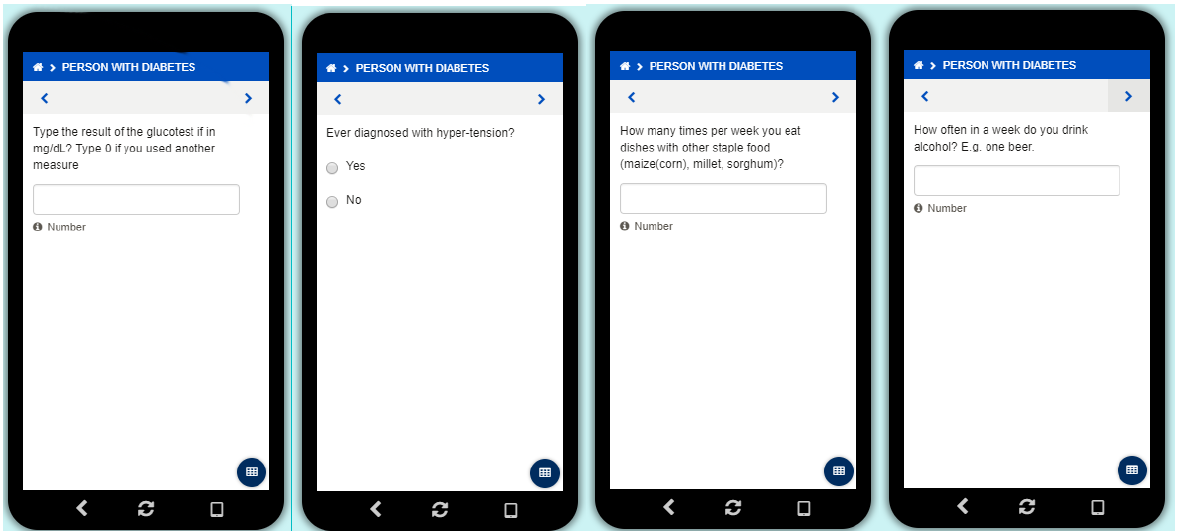
Figure 1. Screen-shots showing some of the guided questions the community nurse were completing while performing the glucose tests. The questions related to diet were based on general consumption for a typical week and not the week at point of